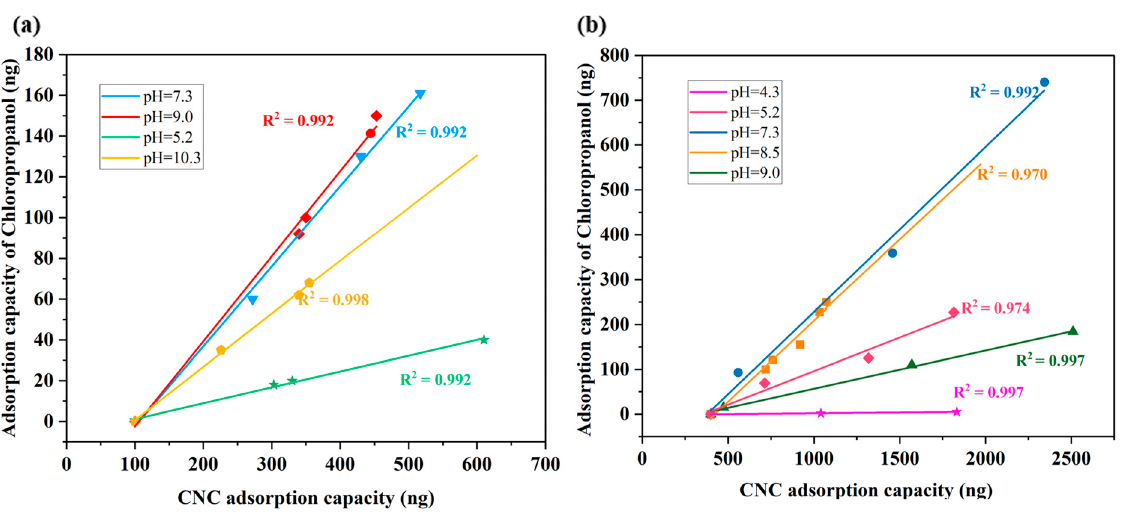
Figure 5. Adsorption capacity of chloropropanol on sulfonated and carboxylated nanocellulose samples.